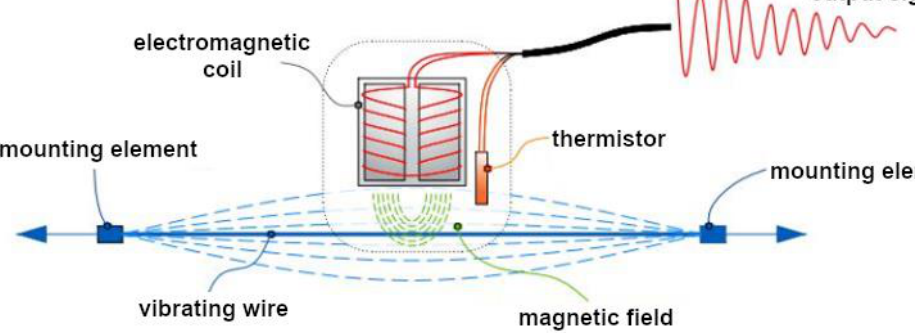
Figure 4. Principle of operation of transducers with a vibrating wire strain gauge [19].